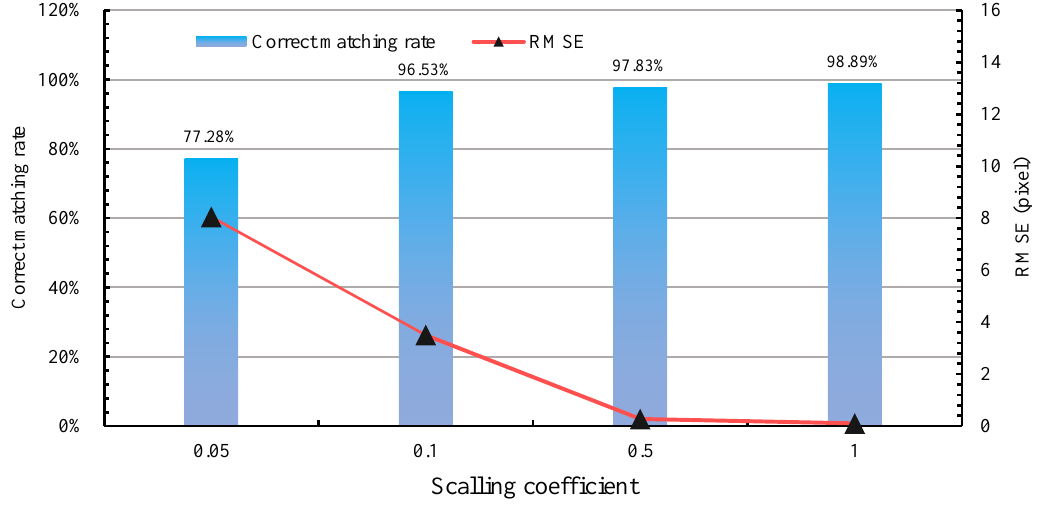
Figure 12. Correct matching rate and RMSE at the different scaling coefficients.